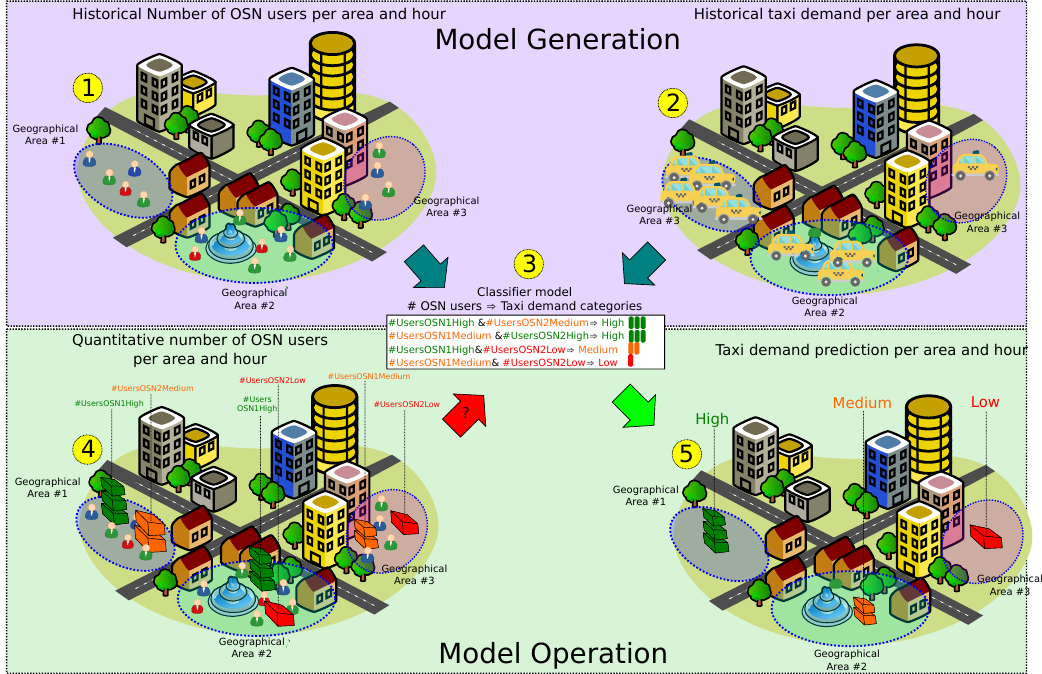
Figure 1. QUADRIVEN (QUalitative tAxi Demand pRediction based on tIme-Variant onlinE social Network data analysis) overview. In Step 1, the sheer number of active OSN users is extracted from two Online Social Network (OSN) platforms (OSN1 and OSN2) in Areas 1, 2, and 3. Similarly, the actual taxi demand in the same areas and time period is extracted in Step 2. In Step 3, a classifier is developed based on the association between the number of users in an area and expected taxi demand in such an area in the short term. In Step 4, the classifier is fed with the number of current active users in the target regions during a time interval. Finally, in Step 5, the predicted taxi demand is generated as categorical data. Notice that the information here is simplified for illustration purpose.